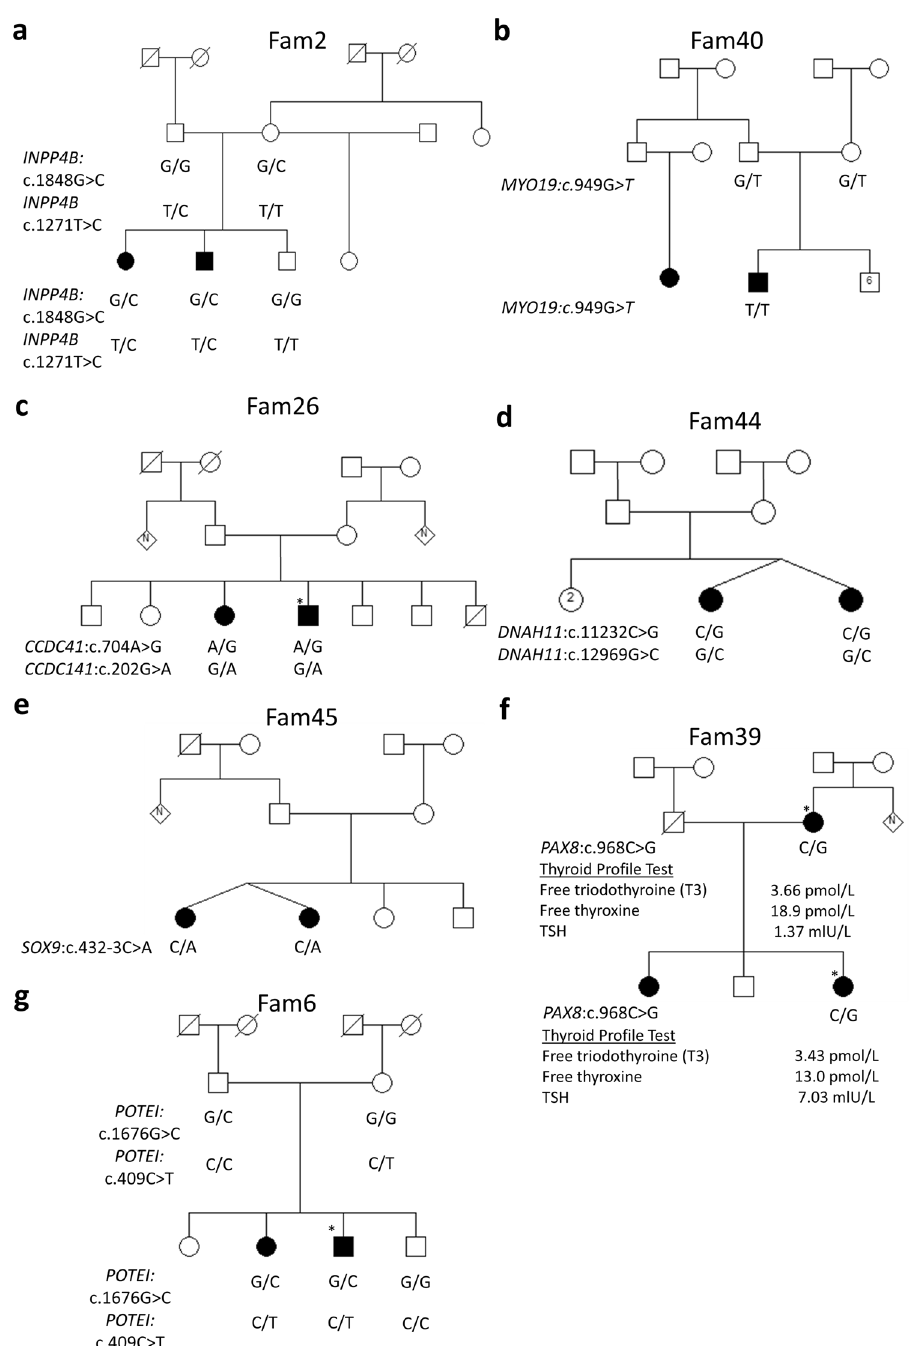
Fig. 3 Pedigrees of families which segregate candidate genes. The segregation of candidate gene variants was shown in the respective families, a Fam2, b Fam40, c Fam26, d Fam44, e Fam45, f Fam39, and g Fam6. *Individuals whose audiogram was